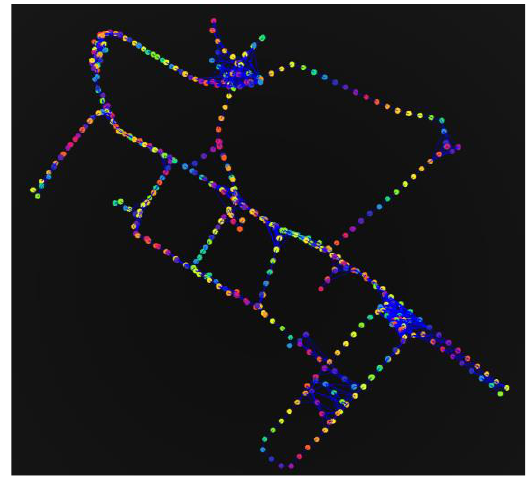
Figure 5. The 444 Local Maps (coloured points) and the 1512 matches (blue segments) generated at the end of the “Global Optimization” phase.